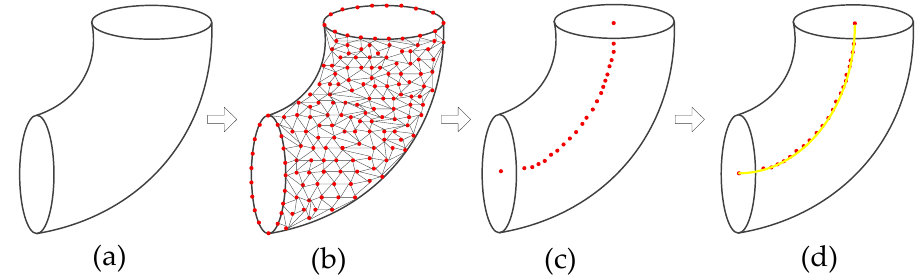
Figure 6. The process of representative edges extraction of an MEP element: ( a ) tanking an MEP element; ( b ) triangulating an MEP element; ( c ) obtaining center points of representative sets; ( d ) extracting representative edges.